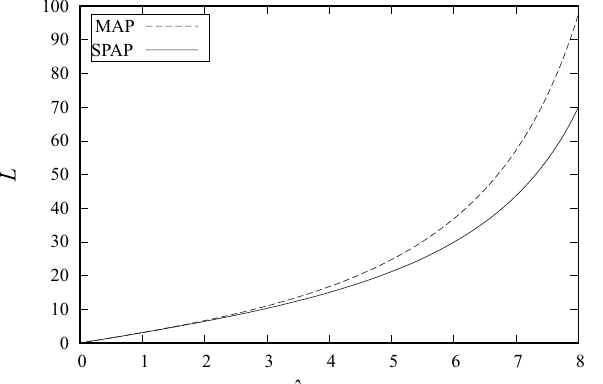
Figure 1. Dependence of the mean number L of customers in the system on the average arrival rate λ .